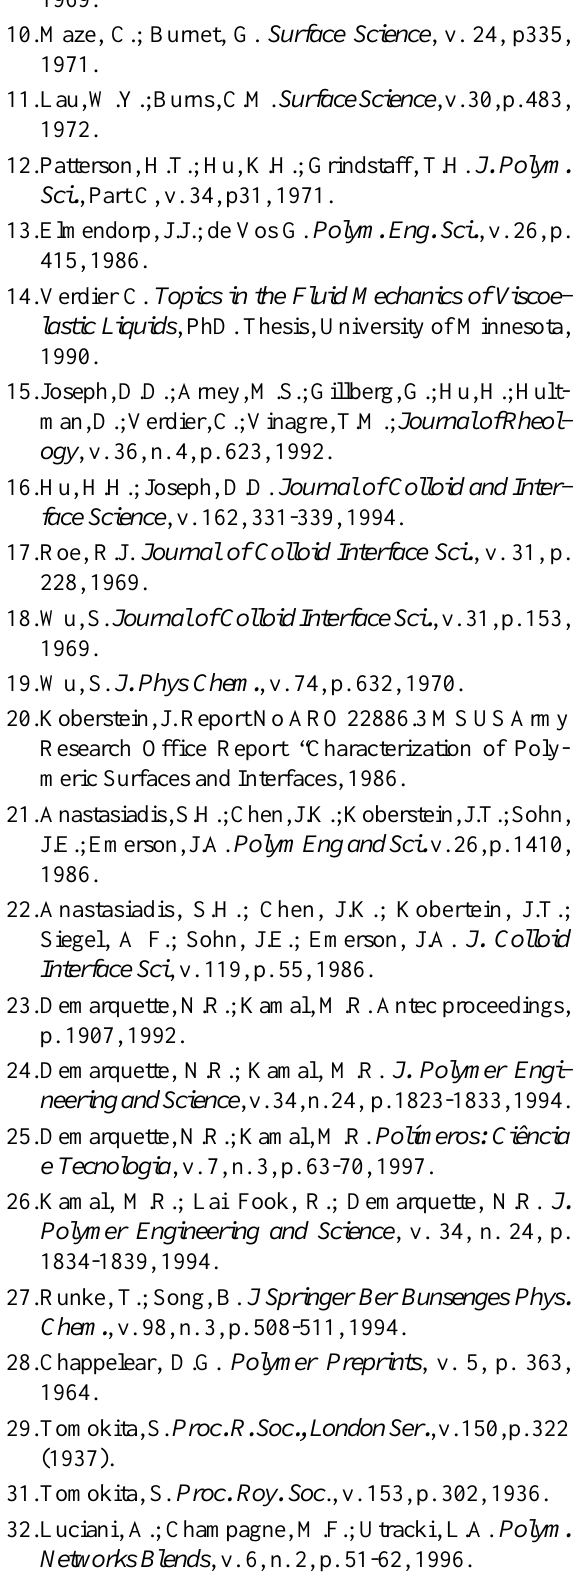
Table 3. Interfacial tension results at 202 °C. Polymer